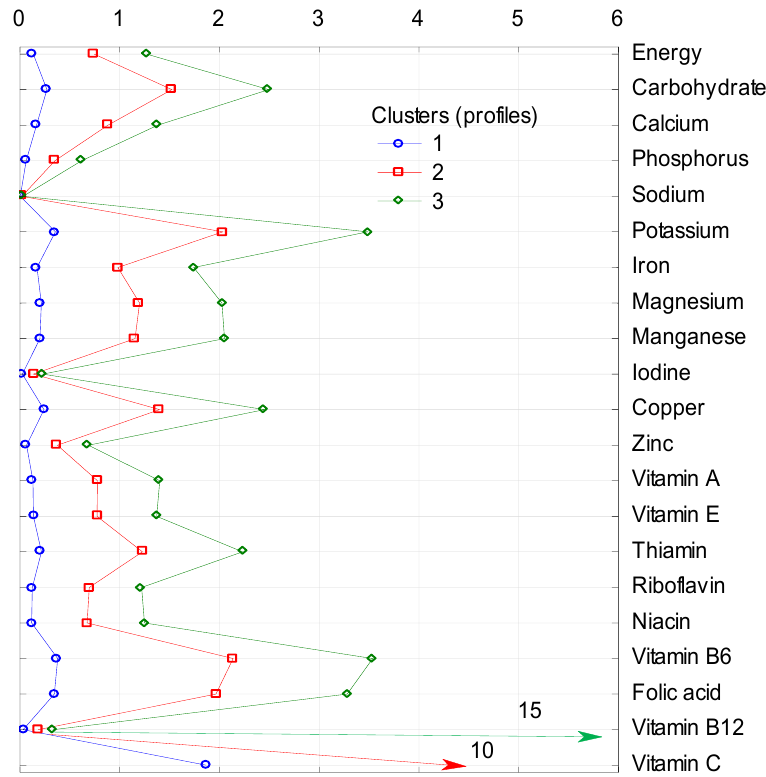
Figure 1. Cluster analysis: supply of energy and analyzed nutrients (in %) from the subgroup of fruit juices to diets in individual clusters. 1, 2, 3—number of clusters; characteristics of clusters are presented in Table 3.